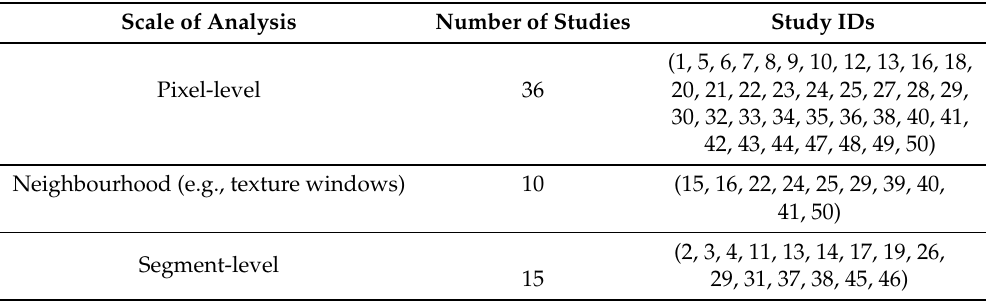
Table 5. Scale at which fusion analysis is conducted in land use-related studies.